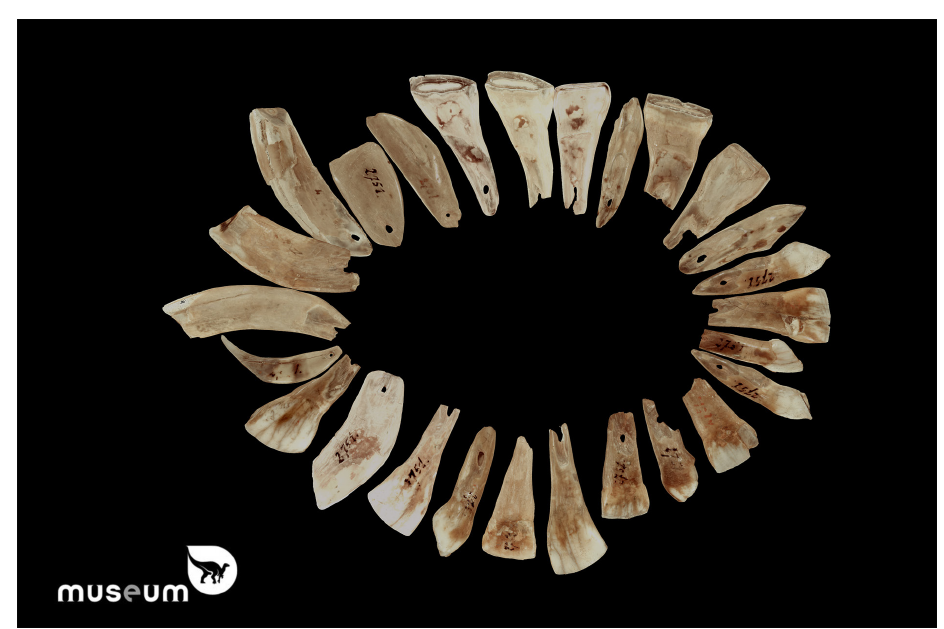
Fig. 3.27. Paleolithic horse-teeth necklace from Goyet, scanned with MechScan and reassemble